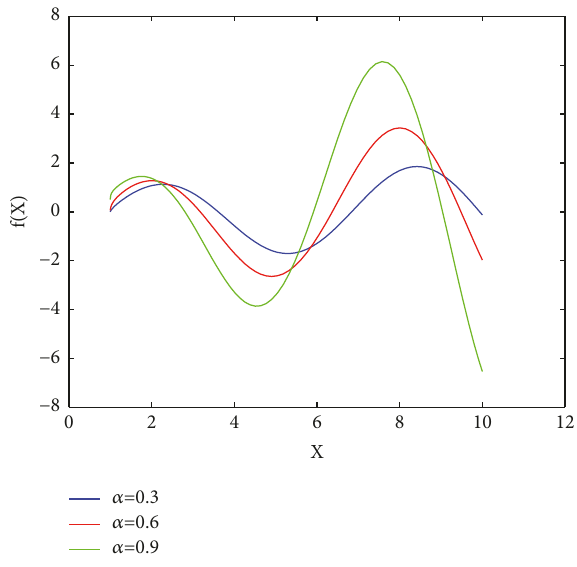
Figure 6: Solution of